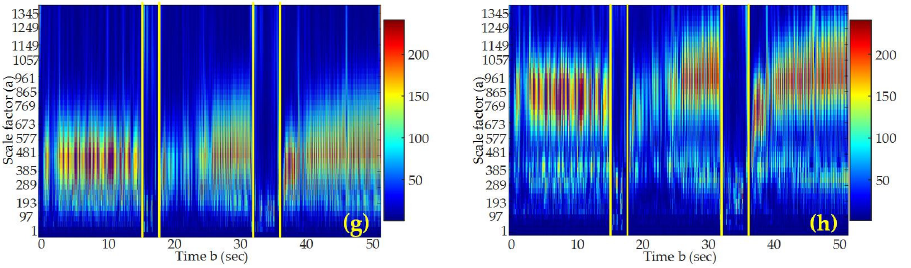
Figure 8. A localization comparison scalogram of the signal shape and leakage signatures using standard mother wavelets, ( a ) Haar, ( b ) bior3.1, ( c ) db12, ( d ) rbio2.6, ( e ) sym8, ( f ) Mexh, ( g ) Morlet, and ( h ) Gaus8. Table 1. The comparison of most correlated mother wavelets parameters regarding the acoustic signal.